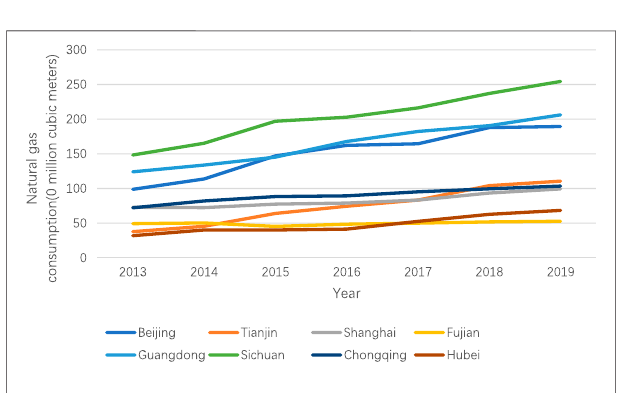
FIGURE 4 | Natural gas consumption in pilot areas after 2013.